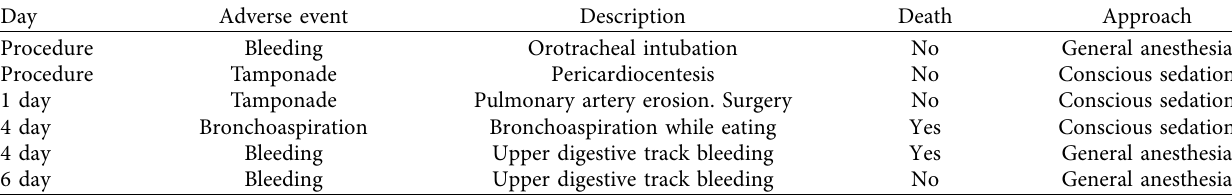
Table 2: Adverse events during first 7 days.